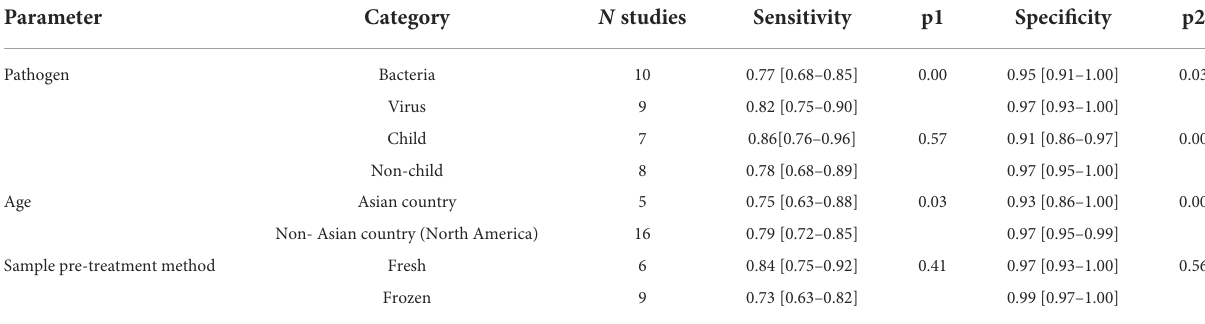
TABLE 1 Subgroup analysis